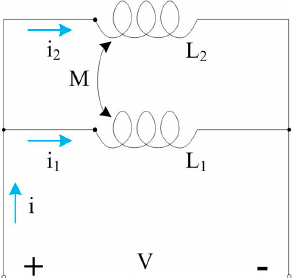
Figure 2. Schematic diagram of inductance detection: L 1 and L 2 are single-layer coil 1 and single-layer coil 2, respectively. i 1 and i 2 are the alternating currents that flow through the two coils.